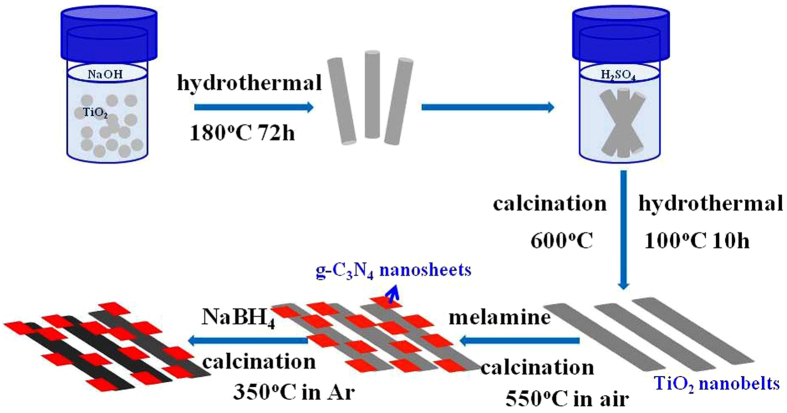
Schematic diagram for the formation of the b-TiO2/g-C3N4 composite.